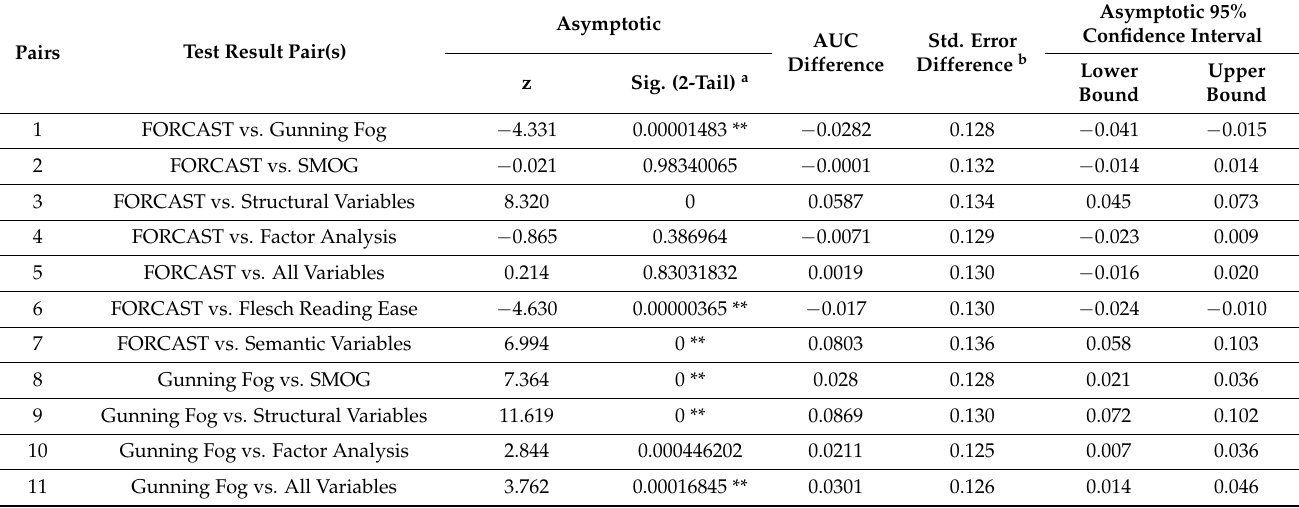
Table 6. Paired-sample t -test of differences in area under the ROC